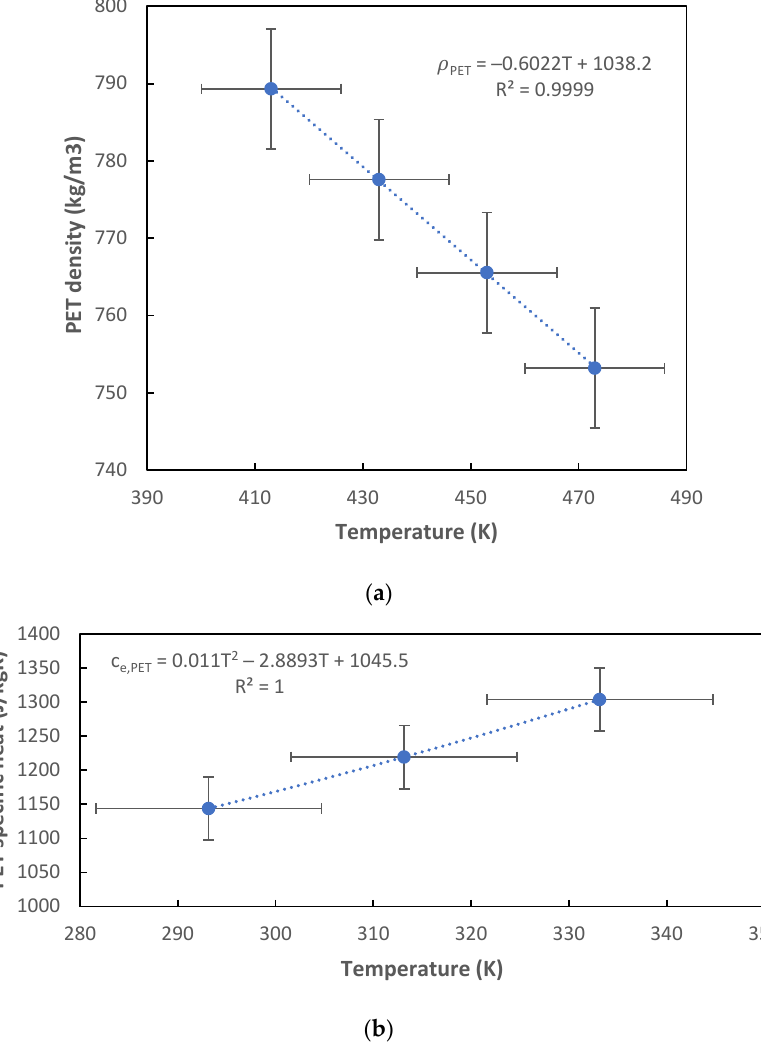
Figure 6. PET relation between material properties and temperature. ( a ) Density and ( b ) Specific heat.